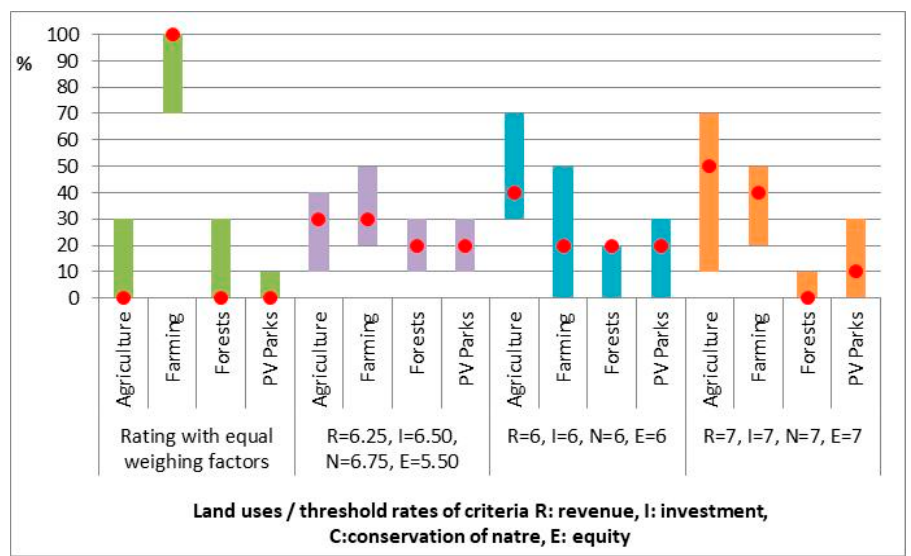
Figure 11. Sensitivity analysis of land uses’ percentages in relation to various sets of threshold values for the examined optimisation criteria.